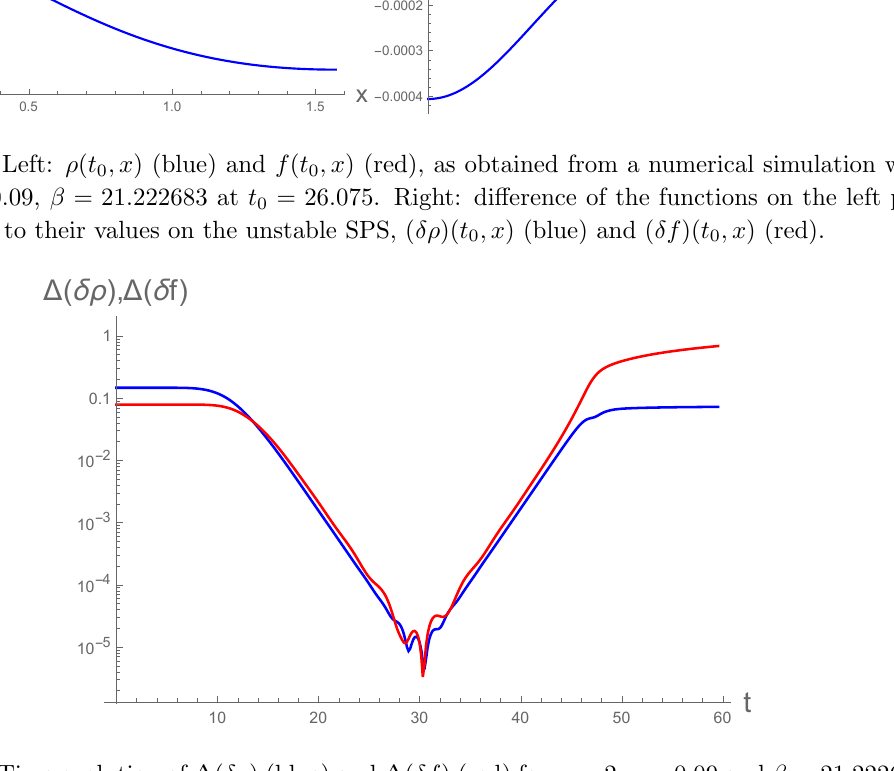
Figure 17 . Time evolution of (cid:1)( (cid:14)(cid:26) ) (blue) and (cid:1)( (cid:14)f ) (red) for ! = 2, (cid:15) = 0 : 09 and (cid:12) = 21 : 222683. We plot these quantities in (cid:12)gure 17. It is clearly seen that there is a time window in